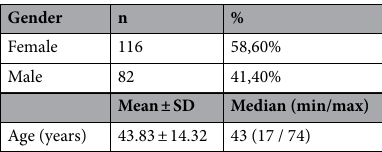
Table 1. Demographic features of the study population (n = 198). SD standard deviation, min minimum, max